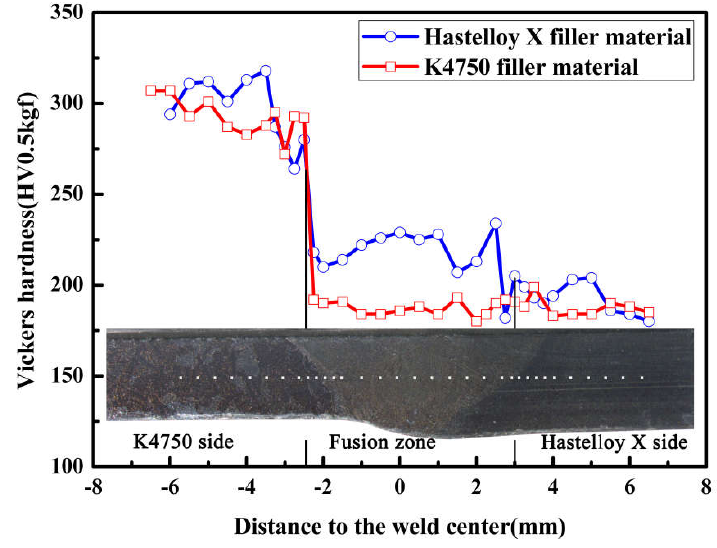
Figure 11. Microhardness distributions of the dissimilar joints with different filler materials.